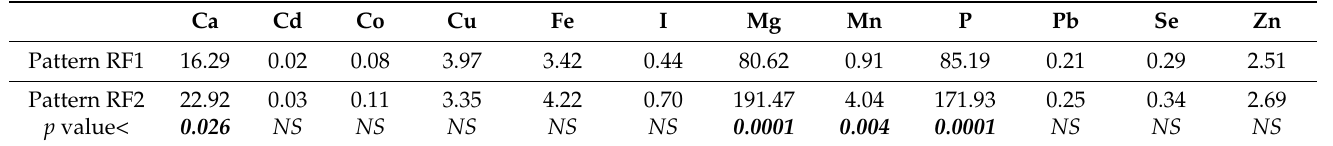
p ≤ 0.05 considered significantly differ between means. NS = Not Significant. All significant values are in